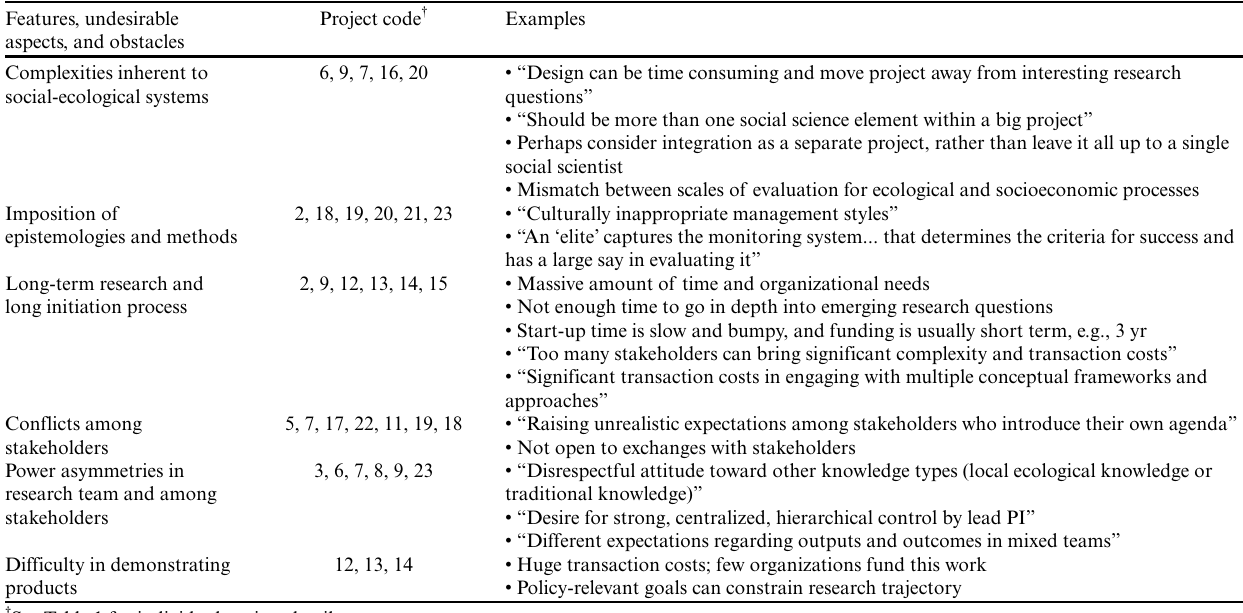
Table 3. Examples of features, undesirable aspects of features, and obstacles that hinder the success of place-based social-ecological sustainability research based on the surveyed projects. Literal quotations are from interviews; other points are summaries elaborated to describe and clump equivalent responses among